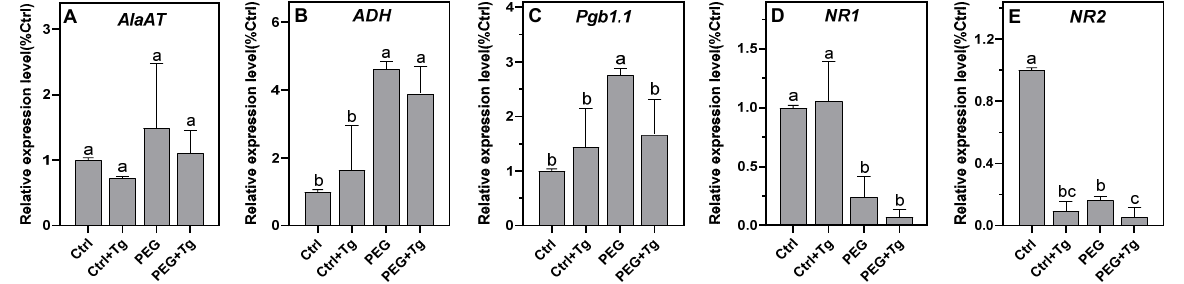
Figure 6. Effects of PEG 6000 osmotic stress and tungstate on the relative expression level of Vicia faba nodule genes: alanine aminotransferase ( A ), alcohol dehydrogenase ( B ), phytoglobin1.1 ( C ), nitrate reductase 1 ( D ) and nitrate reductase 2 ( E ). The relative expression of each gene is expressed as the percentage of the control (T = 0) values. Data are means ± SD of three biological replicates. Letters above the bars represent significant differences according to one-way ANOVA at p < 0.05 (Tukey’s multi-comparison test). AlaAT, alanine aminotransferase; ADH, alcohol dehydrogenase; Pbg1.1, phytoglobin1.1; NR1, nitrate reductase 1; NR2, nitrate reductase 2; PEG, polyethylene glycol 6000; Tg, tungstate.